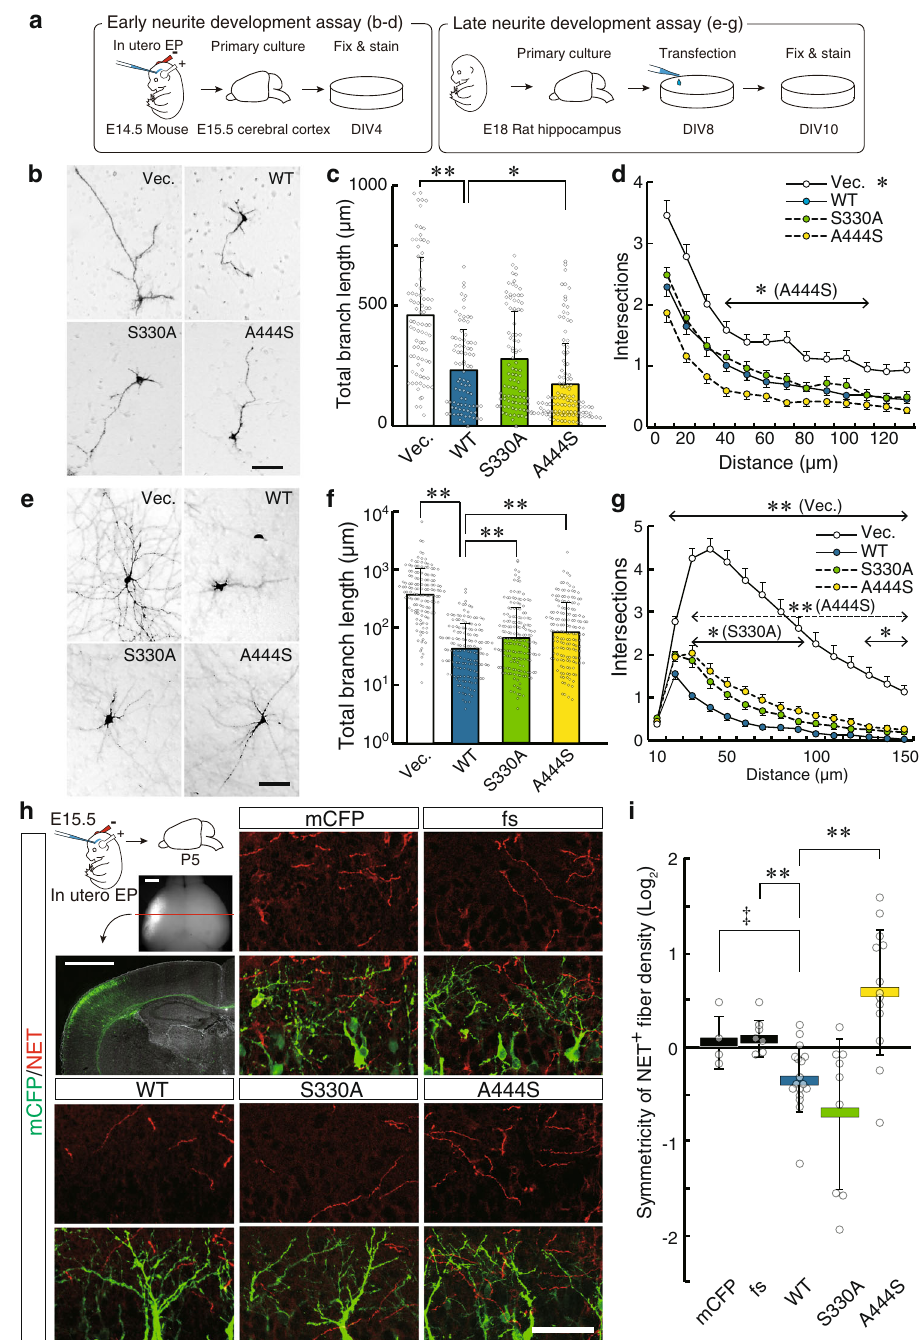
(Fig. 9f, h), which was in agreement with the comparable L1CAM-binding properties between WT and the two variants.